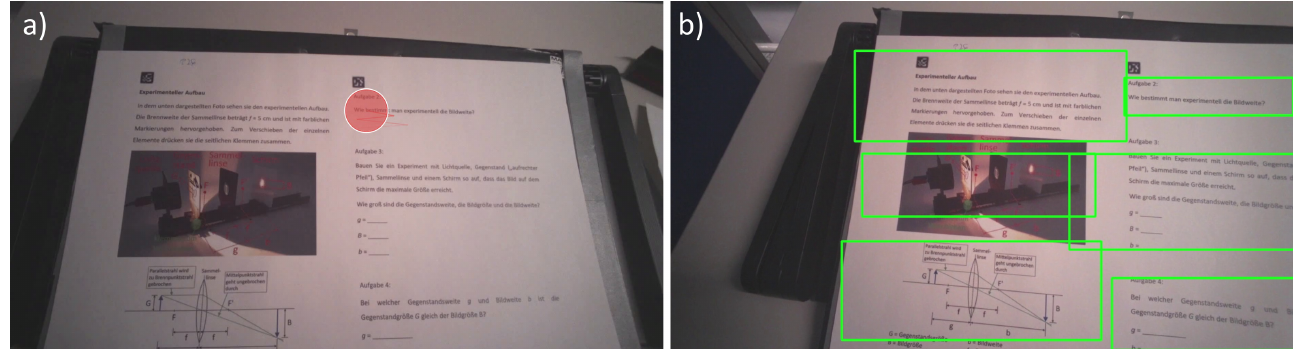
Figure 3. ( a ) A frame from a recorded experimental video with gaze focused on questions. During training and testing, the gaze is excluded from the video. ( b ) A frame from an output video with bounding boxes detected by the trained